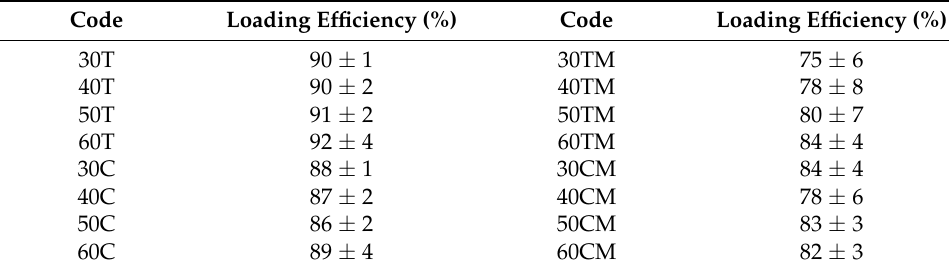
Table 1. Loading efficiencies of different hydrogel